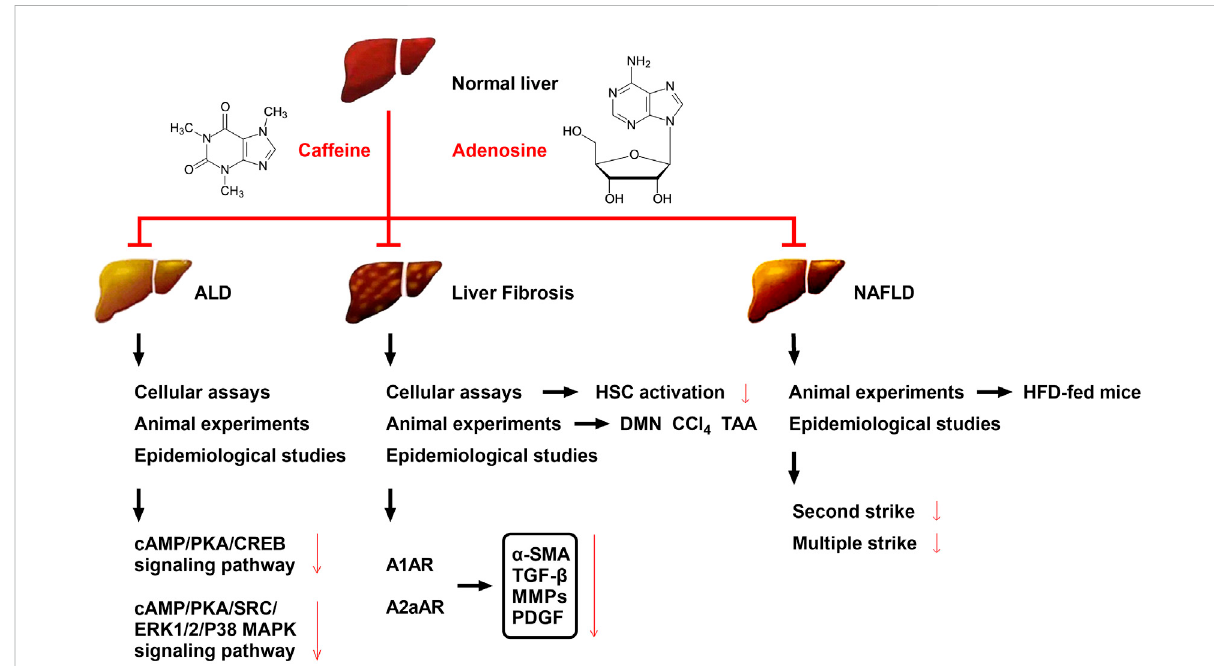
FIGURE 2 Effects andpossible mechanisms ofcaffeineon reducingALD,liver fi brosis, andNAFLD.The mechanism bywhich caffeineattenuatesALDmay be related to its inhibition of the cAMP/PKA/CREB and cAMP/PKA/SRC/ERK1/2/P38 MAPK signaling pathways. The mechanism by which caffeine attenuates liver fi brosis may be related to its competitive inhibition of adenosine and AR binding (mainly A1AR, A2aAR, and A2bAR) in HSCs, which servesto reducethelevels of theextracellular fi brotic cytokines α -SMA, TGF- β ,MMPs, andPDGF. Caffeine has been shownto reducechemical toxicant-induced liver fi brosis in three animal models of liver fi brosis(DMN, CCl 4 , and TAA), and its effect on liver fi brosis has been further con fi rmed by multiple clinical trials. Caffeine attenuates HFD-induced NAFLD in mice, which has also been con fi rmed in several clinical trials; its mechanism may be related to the reduction of liver damage caused by the second strike and/or multiple